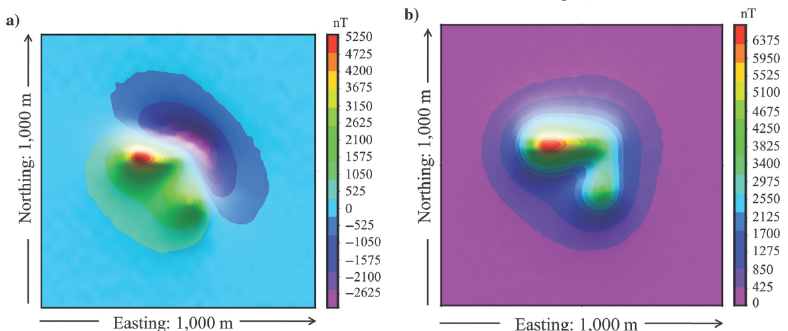
Figure 11. Total-field anomaly ( a ) and magnetic amplitude ( b ) from [29] for a similar two-dike model with a susceptibility of 3